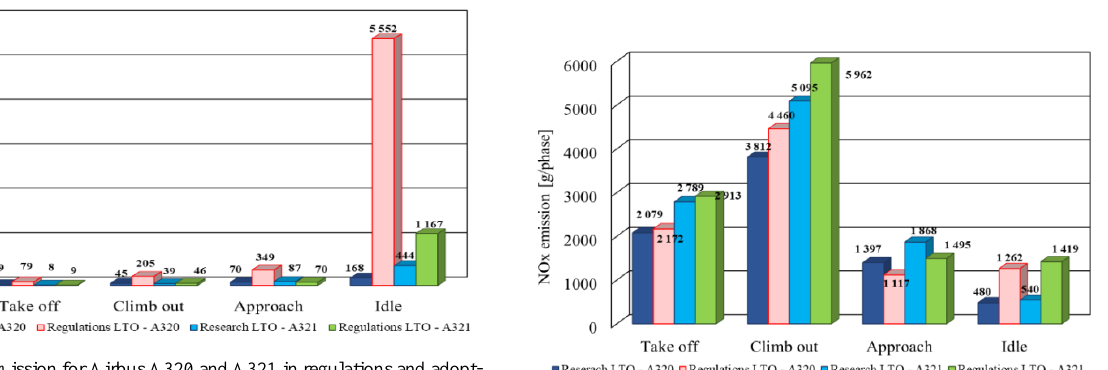
Fig. 12. HC emission for Airbus A320 and A321 in regulations and adopt- ed LTO cycle in each phase